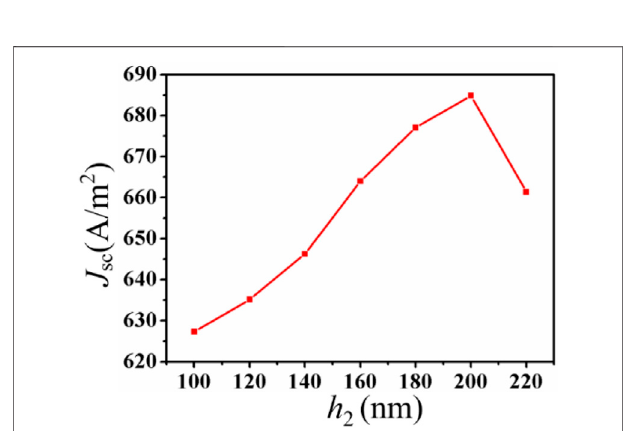
FIGURE 7 | In fl uence of different grating layer thickness on short circuit current.